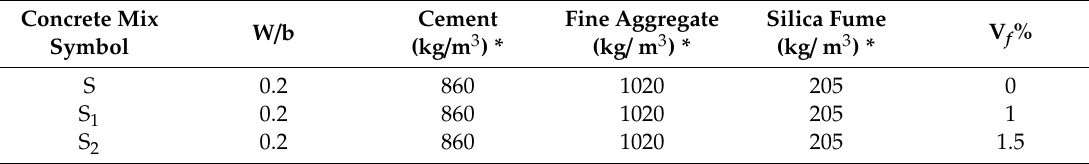
Table 5. The mix proportions used for the RPC specimens. W / b: water to binder